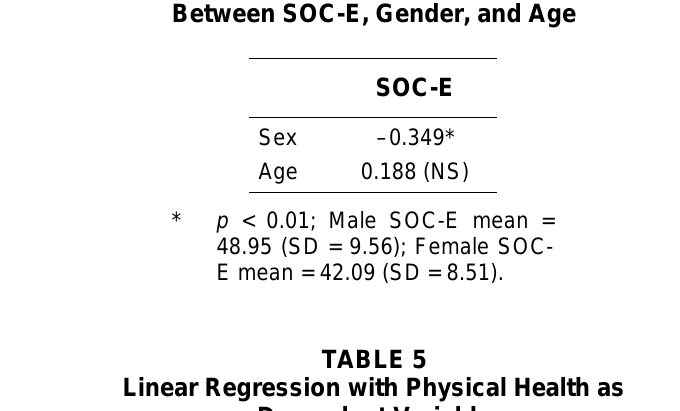
Pearson Correlation Coefficients